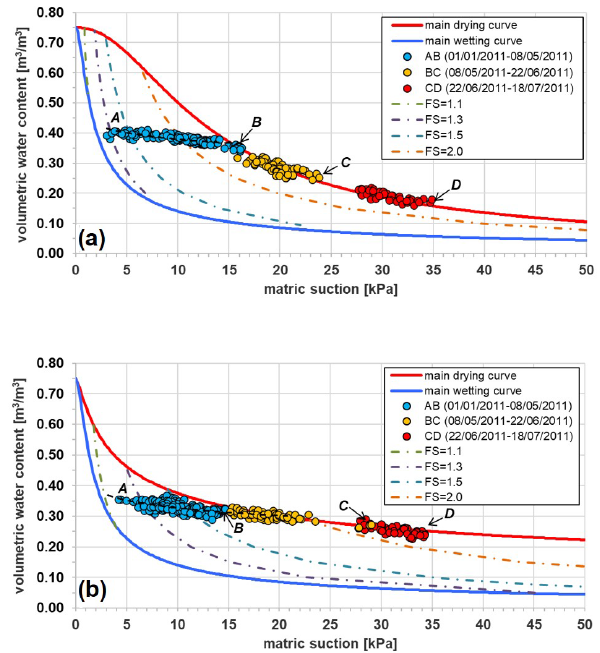
Figure 10. Volumetric water content and matric suction recorded from January to July 2011 at depths z = 0.60m (a) and z = 1.00m (b) and iso–safety-factor curves. The main drying curve at z = 0.60m is obtained by fitting with Eq. (1) all the experimental points monitored from 8 May to 18 July 2011 (the fitted parameters are shown in Table 4). The main drying curve at z = 1.00m is ob- tained by fitting with Eq. (1) all the experimental points monitored from 7 June to 18 July 2011 (the fitted parameters are shown in Table 5). The main wetting curves at both depths coincide with that derived by the infiltration tests (Damiano and Olivares, 2010) shown in Fig. 6. The safety factor, FS, is calculated by Eq. (2), provided by the simplified infinite slope model assuming a homogeneous de- posit with slope angle α = 40 ◦ , unit weight γ = 14kNm − 3 , cohe- sion c (cid:48) = 0, friction angle ϕ (cid:48) = 38 ◦ , θ s = 0 . 75m 3 m − 3 , and θ r = 0.